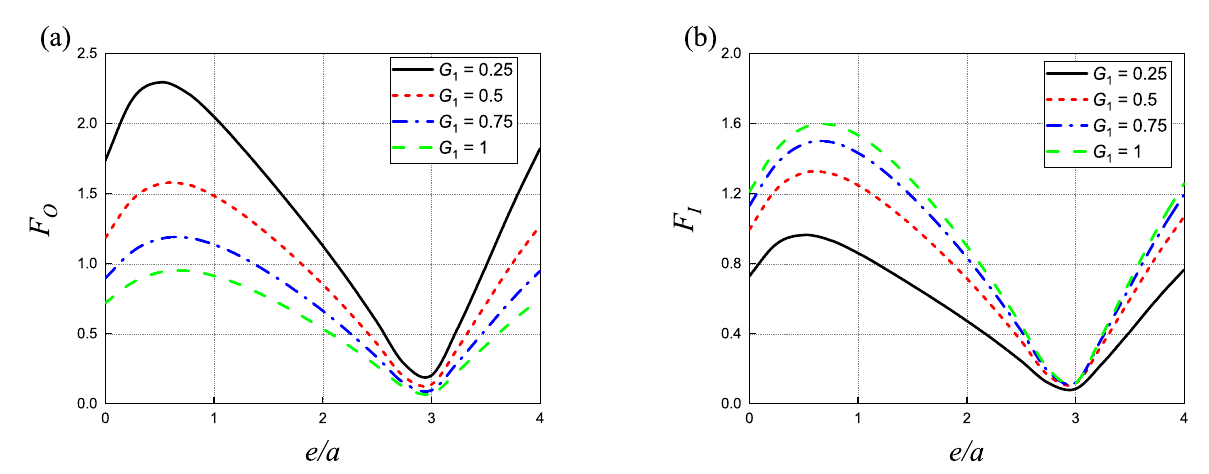
Figure 12. Hydrodynamic forces on the outer and inner cylinders versus e / a for different values of G with C w = 1, β = 0, h / a = 1.5 and c / a = 0.5 : ( a ) the outer cylinder, ( b ) the inner